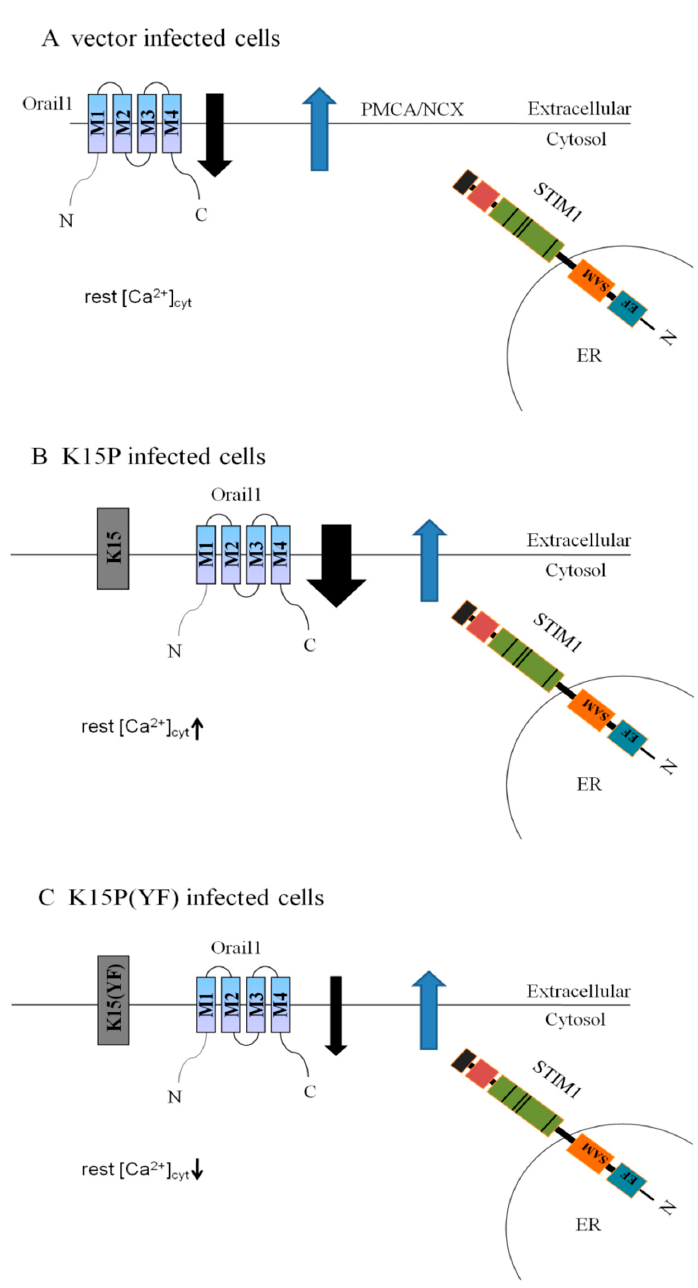
Figure 4. Proposed mechanism of K15-induced disturbance of Ca 2+ influx. ( A ) In the control group with vector infection, [Ca 2+ ] cyt was in equilibrium between Ca 2+ entry by SOCE and Ca 2+ exit by plasma membrane Ca 2+ ATPases (PMCA) and the Na + /Ca 2+ exchanger (NCX). ( B ) In K15P-infected cells, K15P was expressed, inducing an increase of SOCE and an increase of Ca 2+ influx. The residual [Ca 2+ ] cyt levels increased compared with the control and K15P (YF) groups. ( C ) In K15P (YF)-infected cells, the mutant protein induced an decrease of SOCE and Ca 2+ influx, and the residual [Ca 2+ ] cyt levels did not increase compared with other